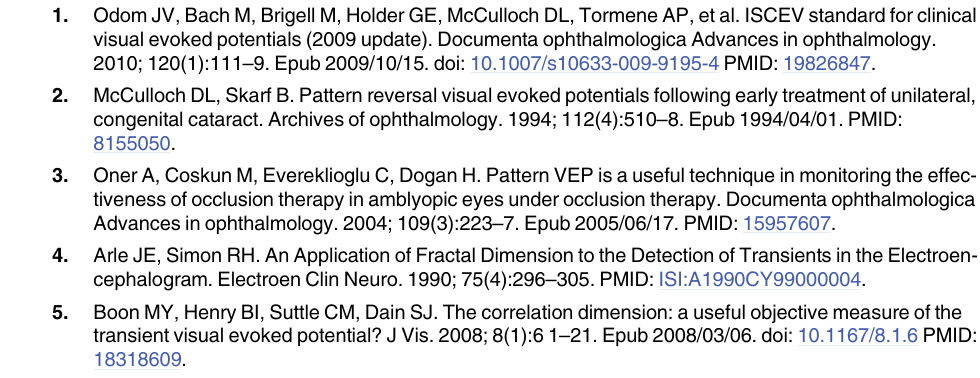
Fig 7. Depiction of the optimised analysis method. Top panel, example VEP. Intermediate panels show plots of log( C ( r )) vs log( r ) and plots of running average slope of log( C ( r )) vs log( r ) as a function of their ordered calculation for m = 1 to 7. The red crosses indicate the data derived from the middle third of the plot log( C ( r )) vs log( r ). The final panel is a plot of D 2 for m = 1 to 7: the ceiling value at m = 7 is an indicator of the fractal dimension of the